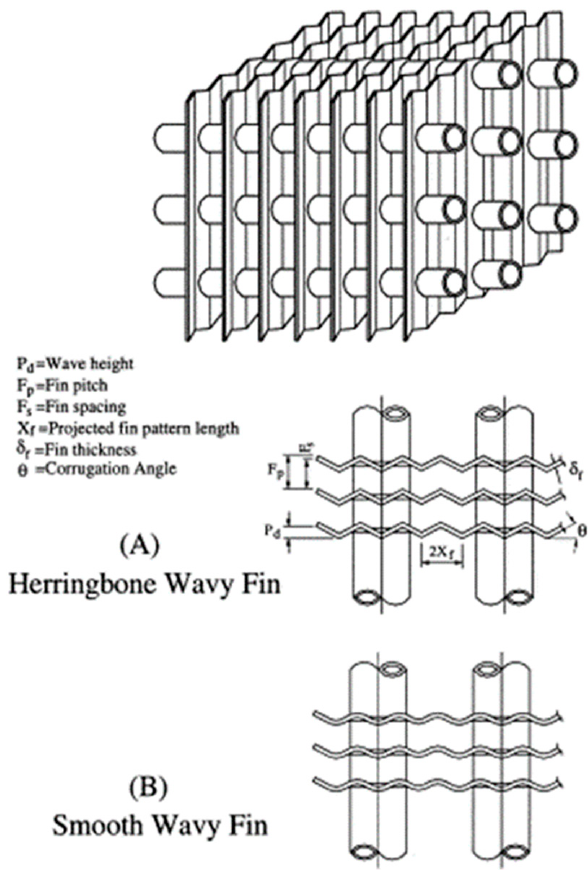
Figure 2. Different fin types for wavy finned tube heat exchangers [9].